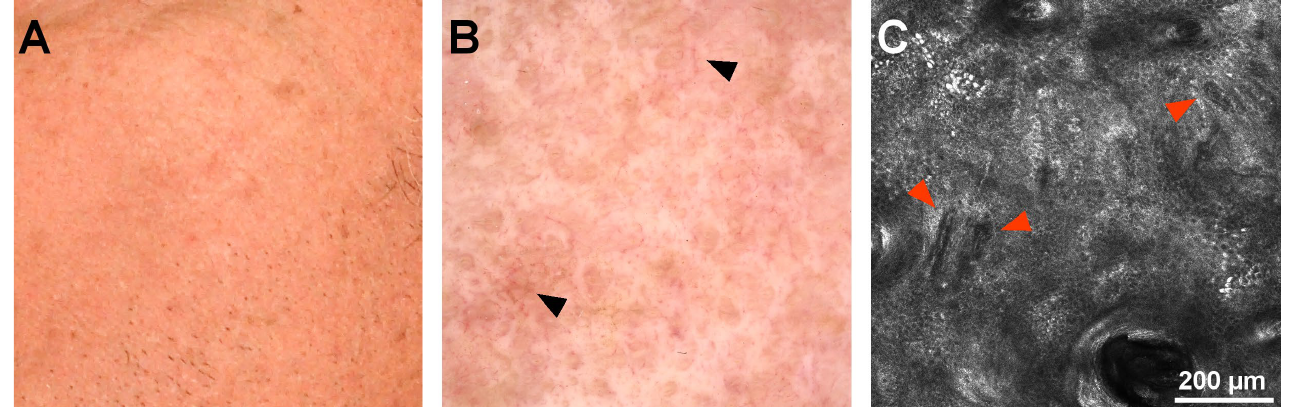
Figure 8. Clinical, dermoscopy, and confocal microscopy (RCM) images of left cheek skin in an 80-year-old male. ( A ). Clinical image of left cheek skin showing uneven texture and some pigmentation. ( B ). Dermoscopy image of the patient revealing pigmentation and longitudinal vessels (black arrowheads). ( C ). RCM mosaic showing longitudinal vessels (red arrowheads) in this 80-year-old male.